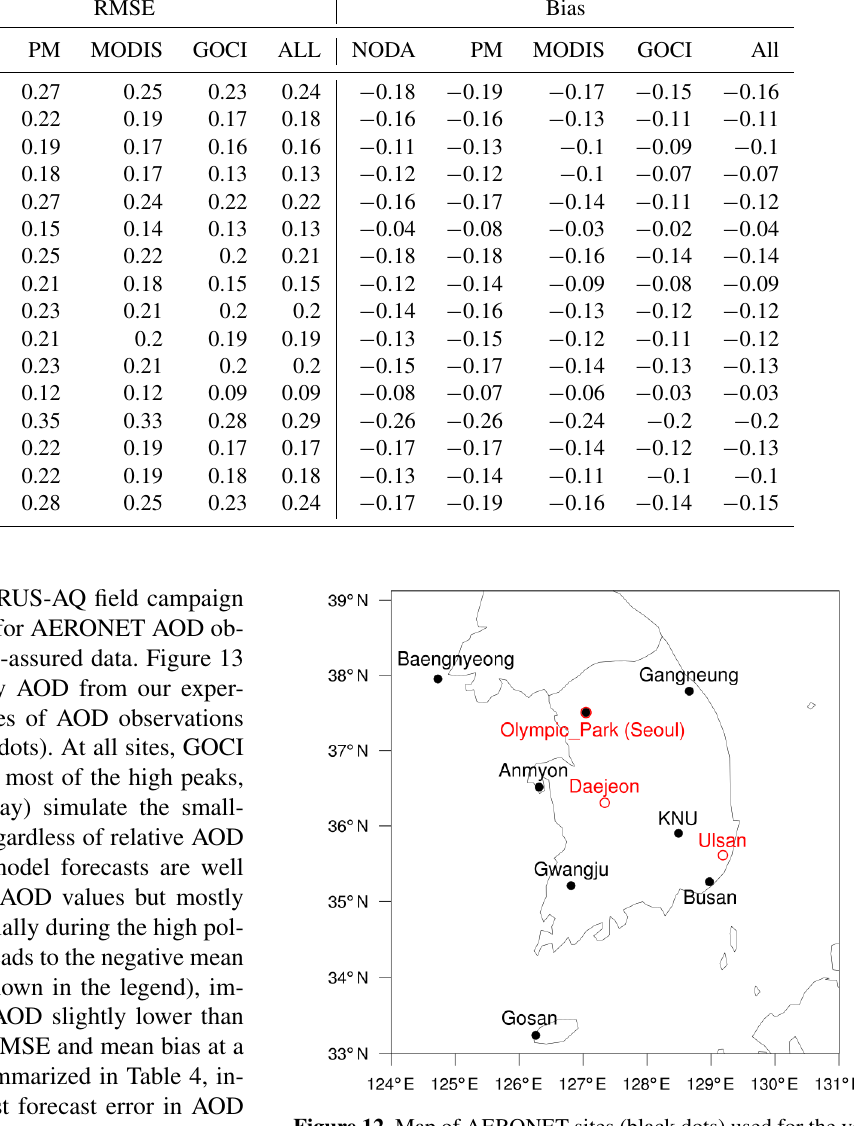
Figure 12. Map of AERONET sites (black dots) used for the verifi- cation shown in Fig. 13. The three red open dots are the stations op- erated by the NIER to measure surface PM 2 . 5 concentrations during the KORUS-AQ field campaign, which are used in the verification illustrated in Fig.